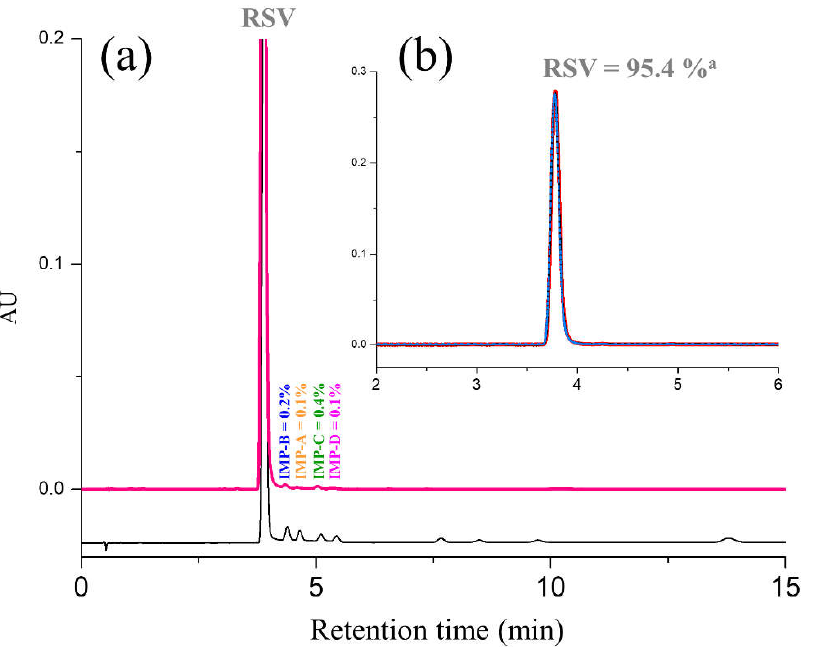
Figure 4. ( a ) Comparison of chromatograms obtained from the analysis of a test solution for impurities (pink line) and an RSV resolution solution (grey line); ( b ) typical chromatograms obtained from the analysis of test solution for assays ( n =3). Chromatographic conditions: column, Acquity BEH C18 (100 mm × 2.1 mm, 1.7 μm); mobile phase, MeOH-TFA 0.025% 45:55 ( v / v ); temperature, 55 ◦ C;